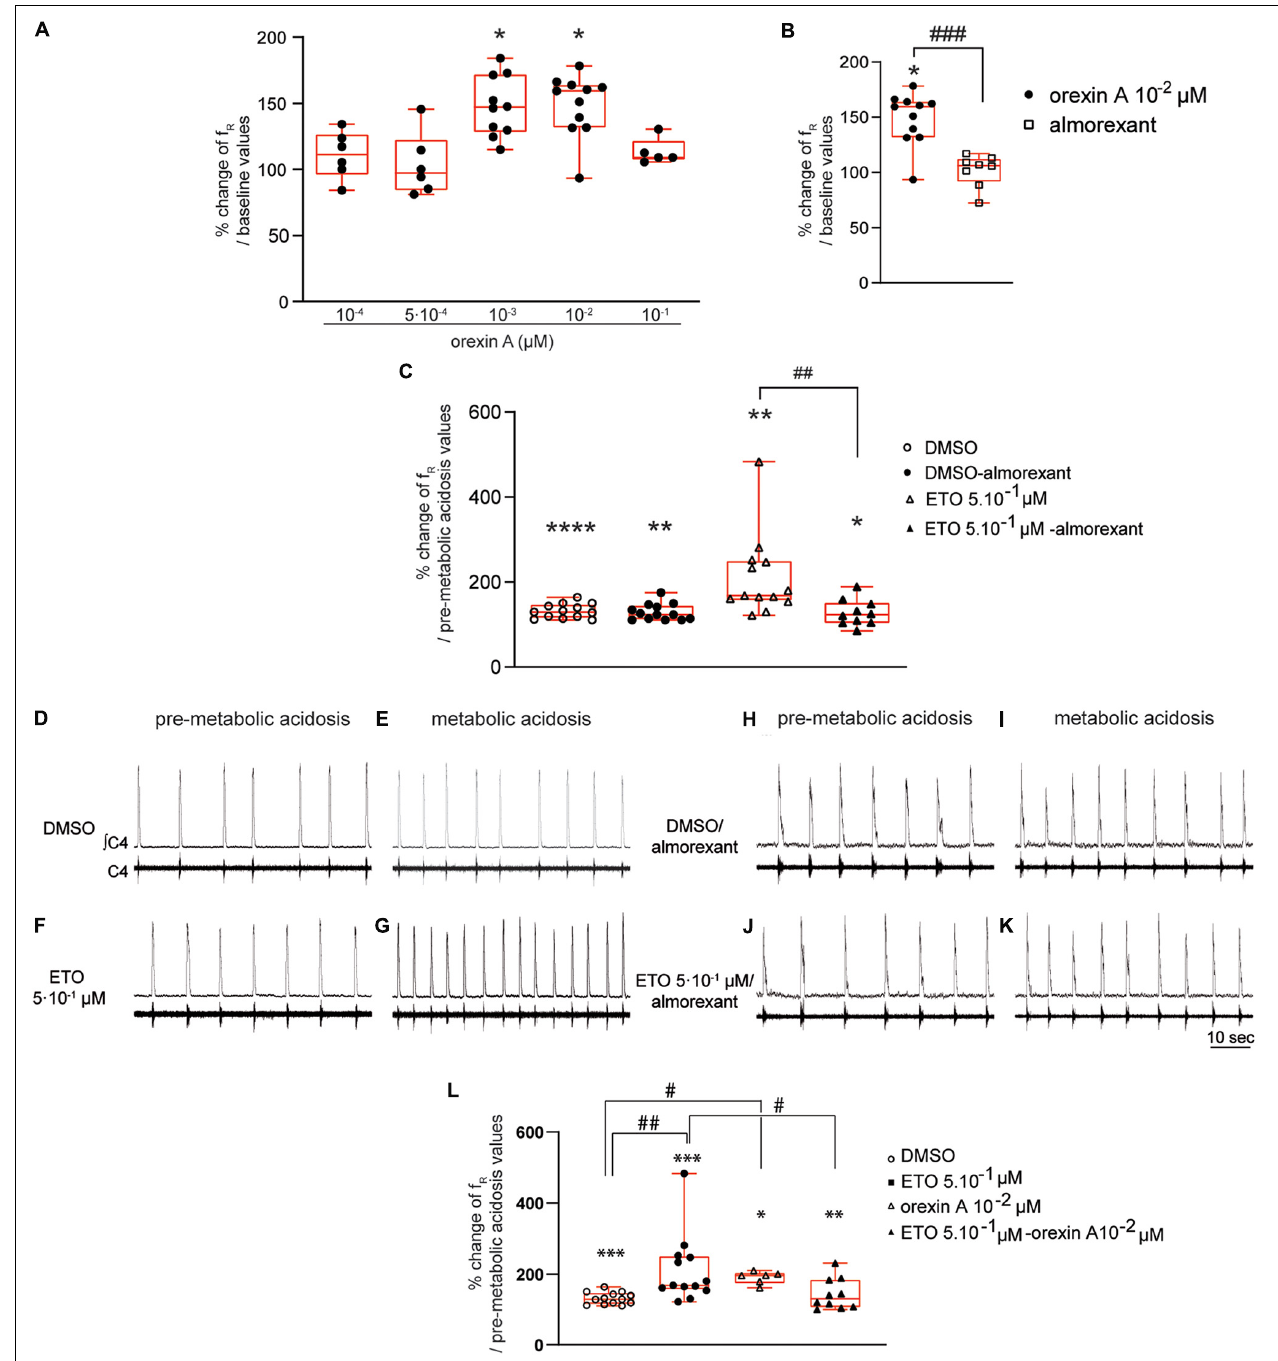
FIGURE 6 | Orexin systems are involved in strengthening of respiratory response to prolonged metabolic acidosis by etonogestrel. Column scatter graph with a superimposed box and whisker plot (median [Q1;Q3]) illustrating percentage of change of f R at 25–30 min of metabolic acidosis at normal pH (A) in the presence of orexin at 10 − 4 ( n = 6), 5 · 10 − 4 ( n = 6), 10 − 3 ( n = 10), 10 − 2 ( n = 11), and 10 − 1 µ M ( n = 5) or (B) in the presence of either orexin alone (10 − 2 µ M, n = 11) or almorexant (10 − 2 µ M) and orexin (10 − 2 µ M) together ( n = 8). ∗ Indicates a significant change [Wilcoxon signed rank test (A) and one-sample t test (B) ] in mean f R relative to baseline values. # Indicates a significant difference [unpaired t -test (B) ] between exposure to orexin alone and co-exposure to almorexant and orexin together. (C) histogram showing mean percentage change of f R under conditions of prolonged metabolic acidosis in the presence of either DMSO or ETO alone (DMSO n = 13 and ETO n = 13) or with almorexant (DMSO n = 13 and ETO n = 10). ∗ Indicates a significant intragroup change (one-sample t test) in mean f R relative to values obtained just prior to placing under conditions of metabolic acidosis. # Indicates a significant difference (one-way ANOVA followed by Bonferroni’s multiple comparison test) between groups.Data are expressed as the mean ± SEM. ∗ p < 0.05, ∗∗ p < 0.01, ∗∗∗∗ p < 0.0001, ## p < 0.01, ### p < 0.001.